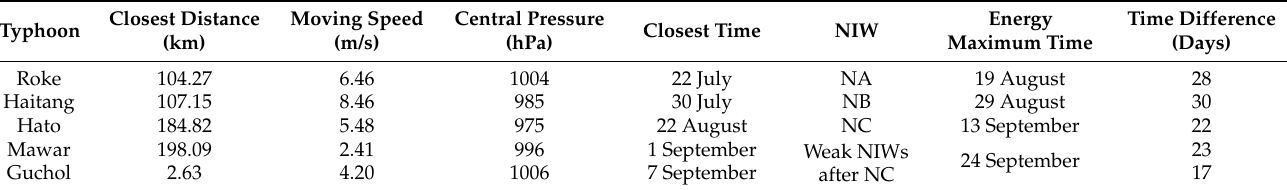
Table 1. Characteristics of the five typhoons when they were closest to